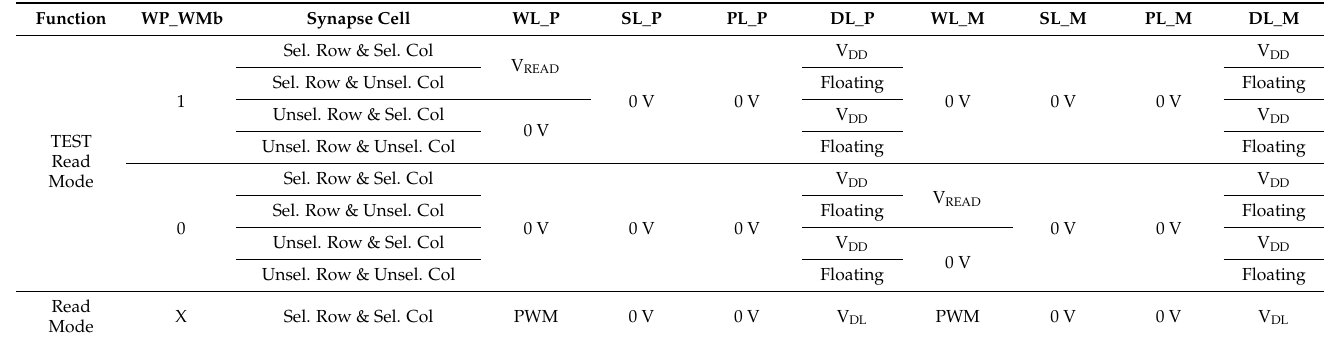
Figure 10. WL driving circuit in the first layer.